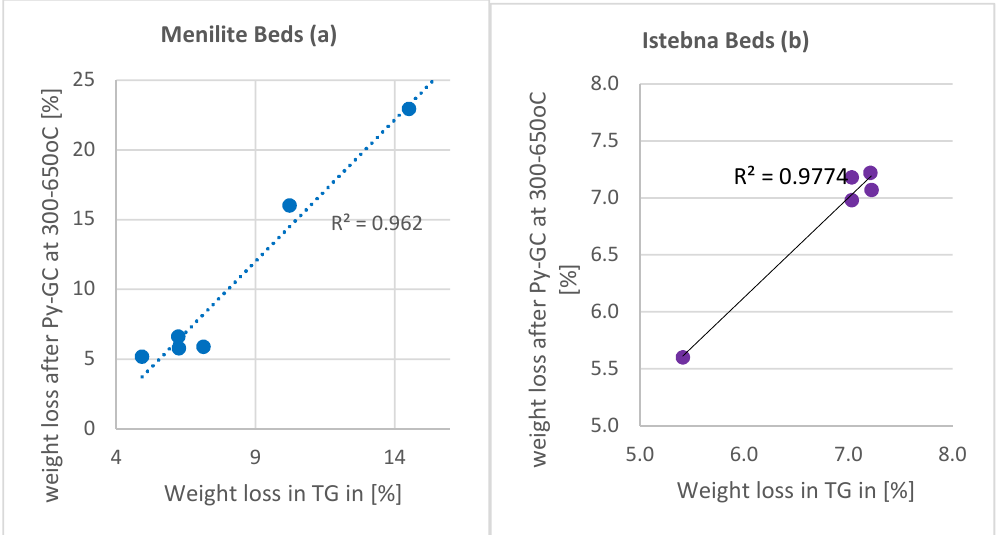
Figure 9. Correlation of Py/GC and TG results in the temperature range of 300–650 °C for samples from the Menilite ( a ) and Istebna Beds ( b ).